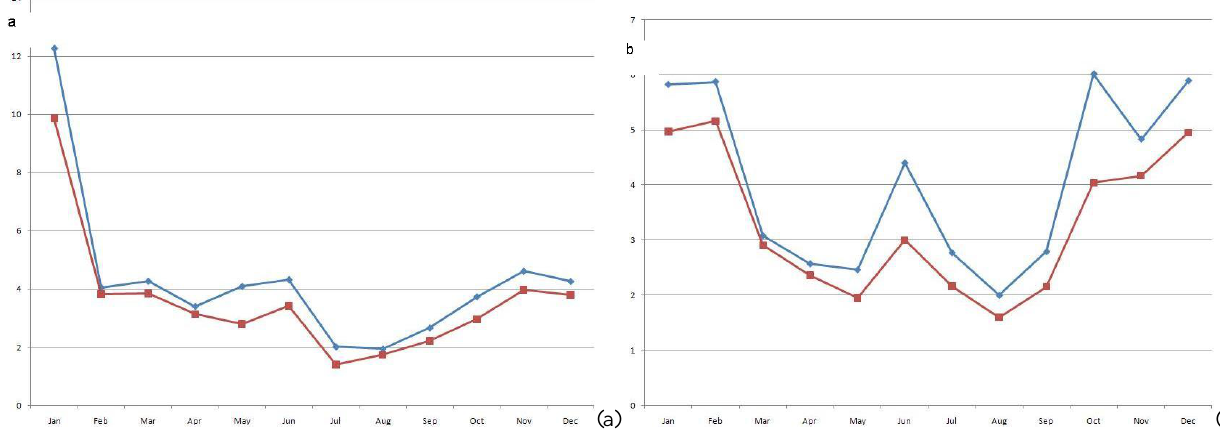
Fig. 10. Mean Absolute Error for 2008 (a) and 2009 (b) on a monthly basis for HE (blue line) and COMB (red line).